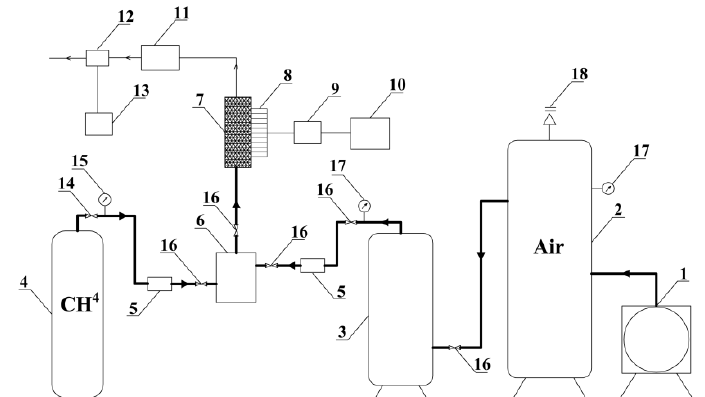
Figure 1. Diagram of experimental system. (1. Air compressor; 2. Gas tank; 3. Oil–gas separator; 4. Methane tank; 5. Mass flow controllers; 6. Premixed chamber; 7. Combustor; 8. Thermocouples; 9. NI-apparatus; 10. Computer; 11. Portable sample system; 12. Gasmet DX4000 gas analyzer; 13. Laptop computer; 14. Relief valve; 15. Pressure gauge for methane; 16. Check valve; 17. Pressure gauge for air; 18. Safety valve).